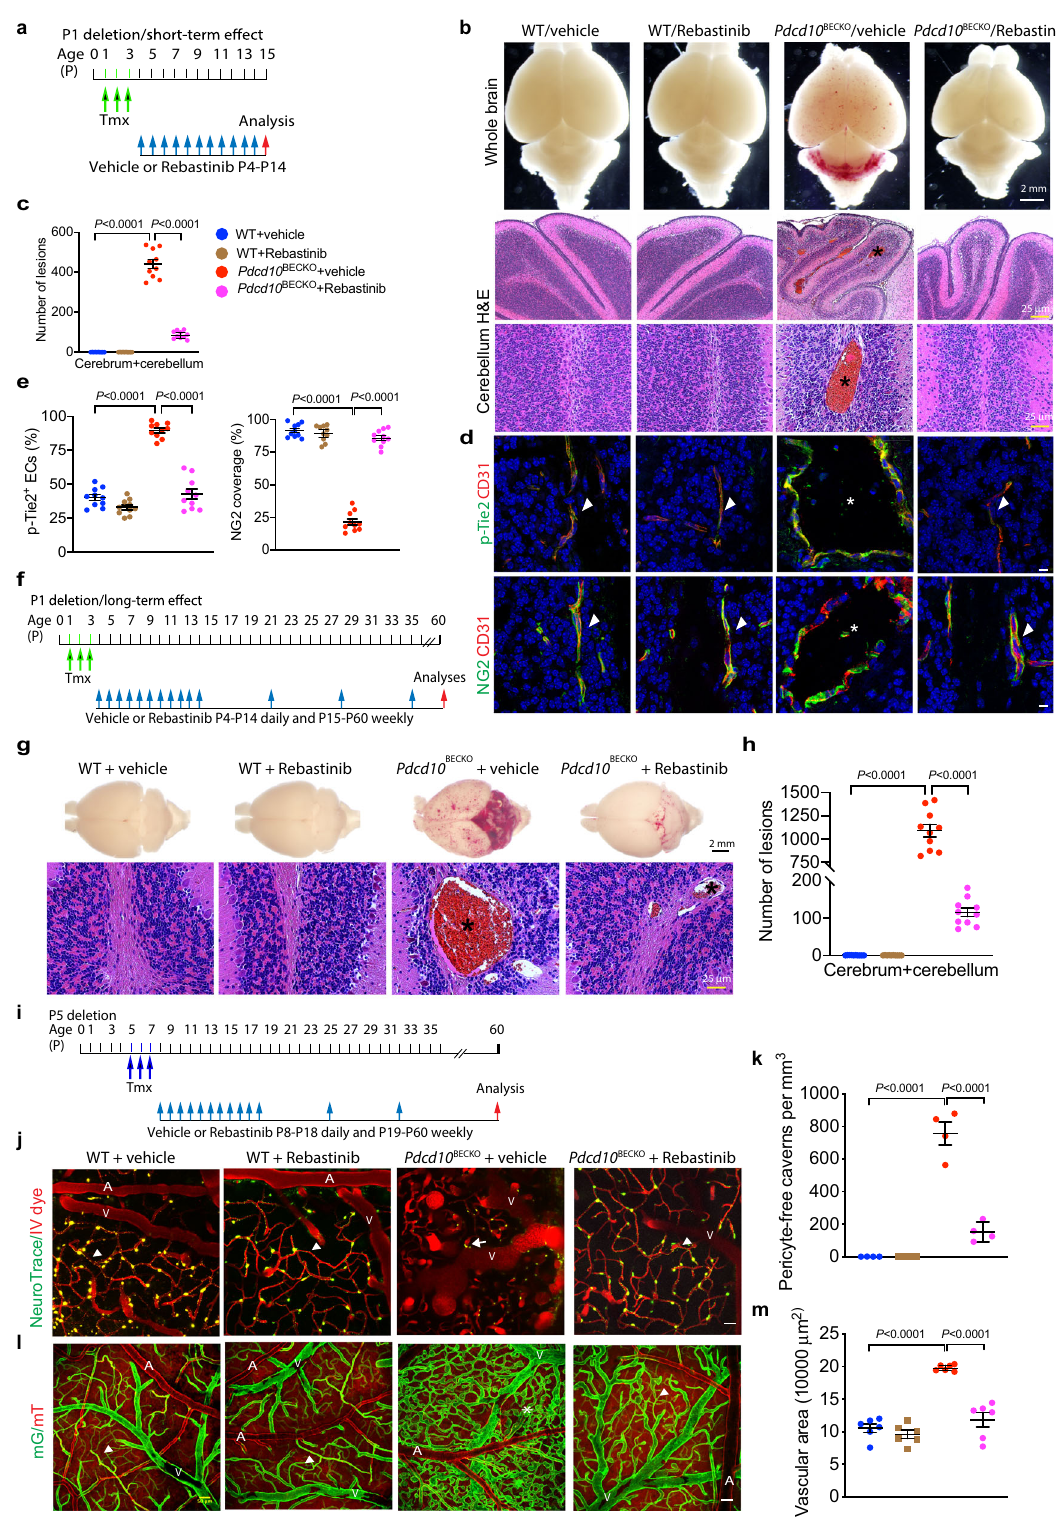
and provided with food and water ad libitum, temperature was between 20 and 24°C and relative humidity between 45 and 65 rH. Mice were cared for in accordance with the National Institutes of Health guidelines, and all procedures over the exposed area and sealed with dental cement. For all experiments, mice were approved by the Yale University Animal Care and Use Committee. were imaged whilst anesthetized with a mixture of ketamine and xylazine as stated above. For repeated in vivo imaging, a nut was af fi xed to the skull and embedded in dental cement for head immobilization and window orientation. Cerebral vessels were visualized by intravenous (i.v.) injection of EBD. In vivo images were acquired Cranial window preparation and in vivo imaging using an upright Leica SP5 confocal microscope. A ×20 water immersion objective Mouse cranial windows . Windows were prepared as previously described 56 . Brie fl y, (1.0 NA, Leica) was used for optimal fl uorophore excitation and emission animals were anesthetized via i.p. injections of 100 mg/kg ketamine and 10mg/kg NATURE COMMUNICATIONS| (2021) 12:504